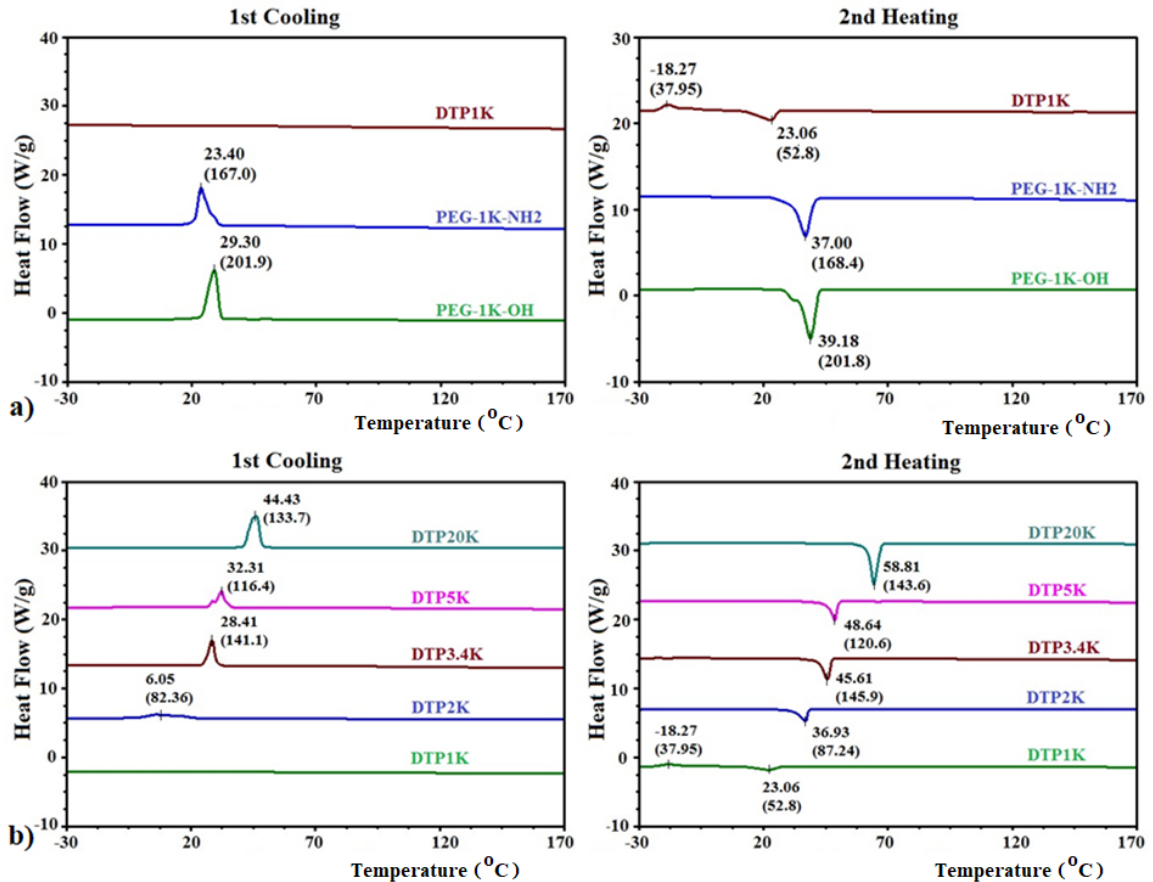
Figure 2. Comparative differential scanning calorimetry (DSC) thermograms (5 °C/min heating/cooling rate) of ( a ) polyethylene glycol (PEG)-1K-OH and PEG-1K-NH2 versus PEGylated bis-sulfonamide DTP1K 28 and of ( b ) PEGylated bis-sulfonamides DTP2K 23 and DTP1K 28 –DTP20K 31 : values in parentheses are the integrated heat signals. Tc and Tm were heating/cooling-rate dependent (data not shown).